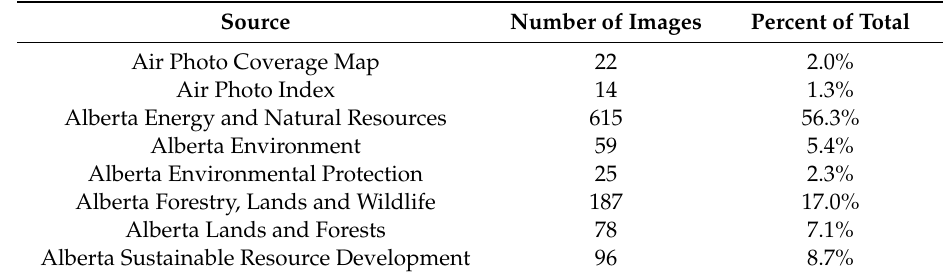
Table 2. Aerial photographs by source from 1949 to 2008 for the lower Athabasca River from Fort McMurray, AB to Fort Chipewyan, AB, including the Peace-Athabasca Delta ( n = 1100 images).